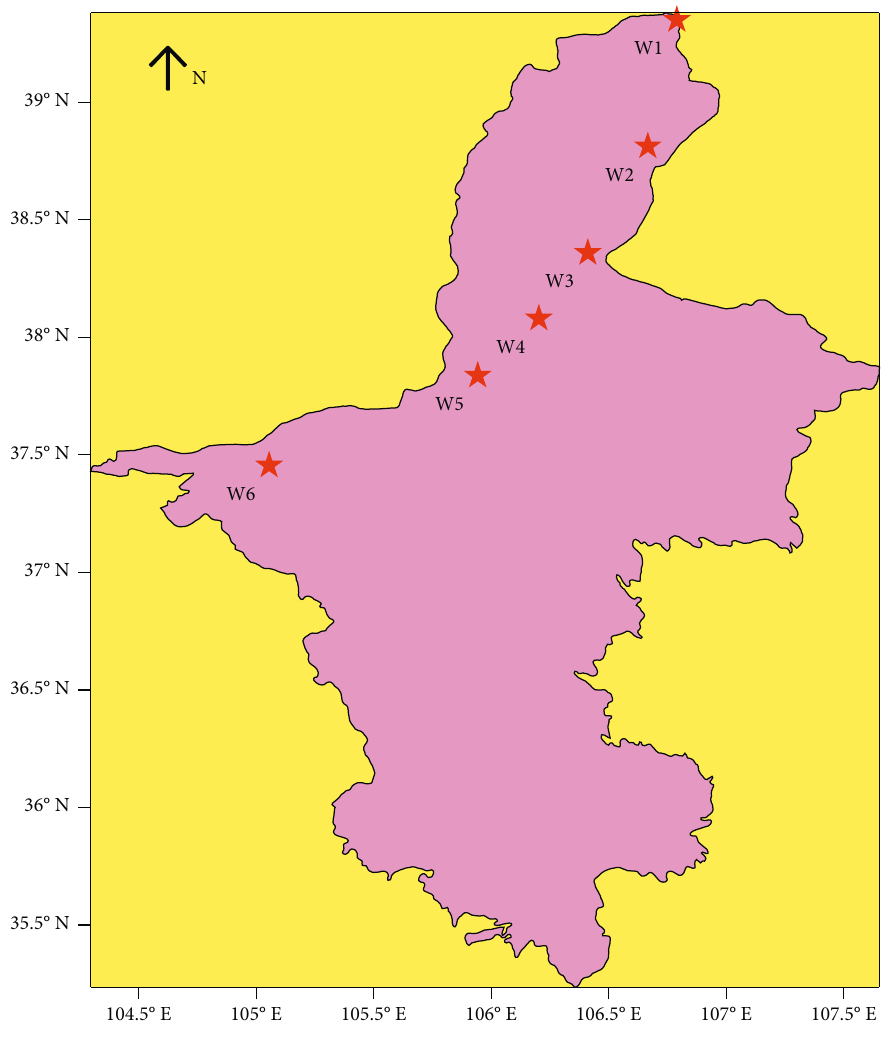
Figure 1: Sampling sites of this